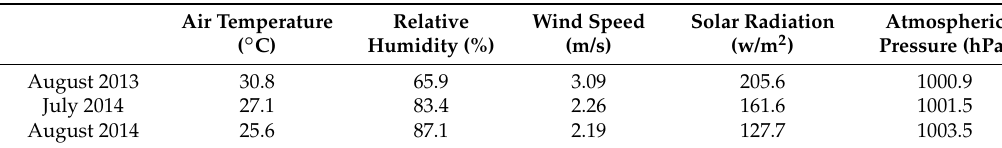
Table 1. Comparison of meteorological conditions during the different periods.